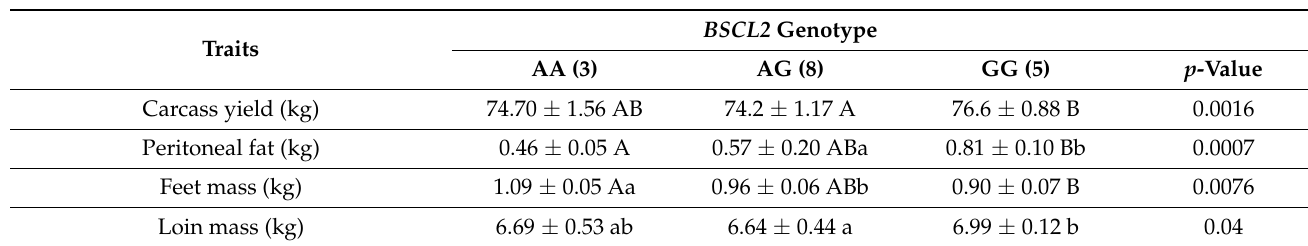
Table 3. Means with standard deviation (SD), calculated based on ANOVA test (SAS) for pig production traits dependent on rs330154033 BSCL2 variant, for 16 Złotnicka White pigs included in RNA sequencing